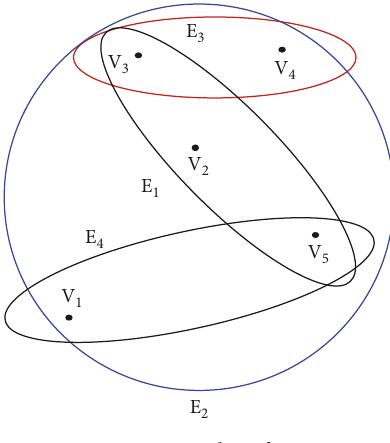
Figure 3: Strong edge of IFHG H.